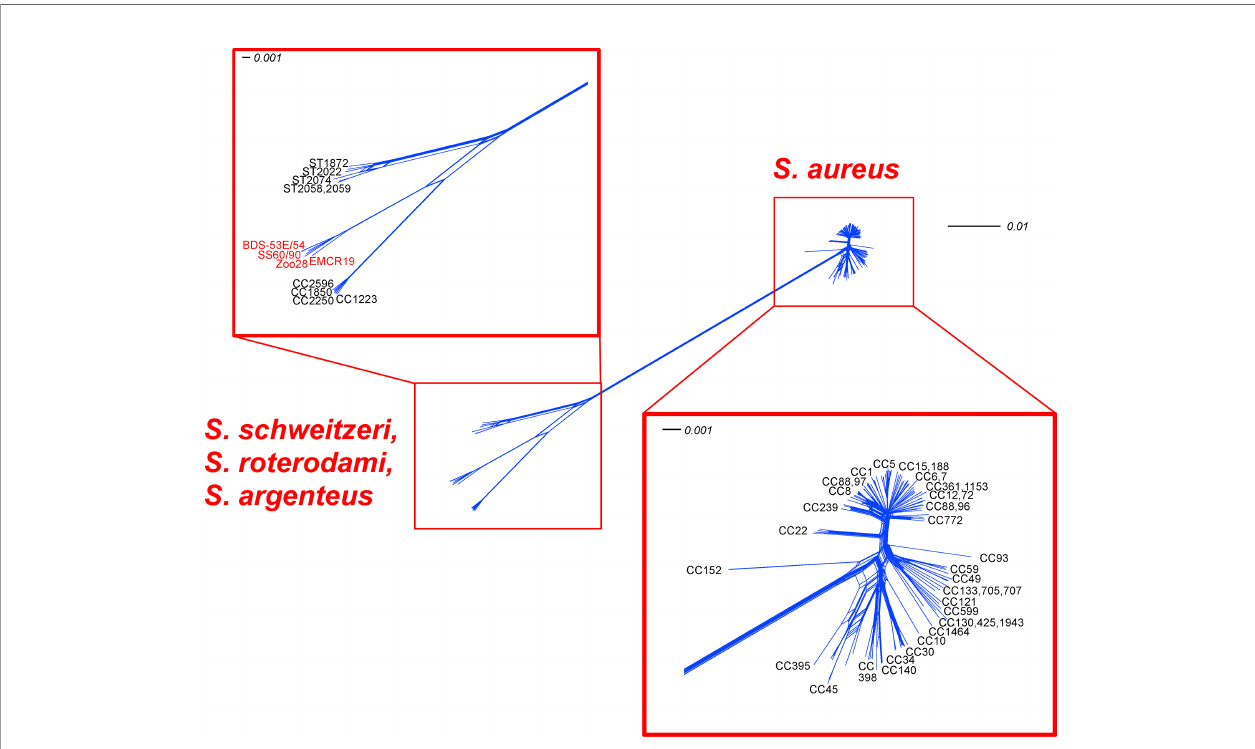
FIGURE 1 | SplitsTree analysis for 154 core genomic markers of the study isolates, “ S. roterodami ” EMCR19 as well as “ S. singaporensis ” SS60 and SS90 compared to diverse S. aureus, S. argenteus and S. schweitzeri CCs. Note, for the genes that were found inverted in the Zoo-28 genome, reverse complement sequences were used for